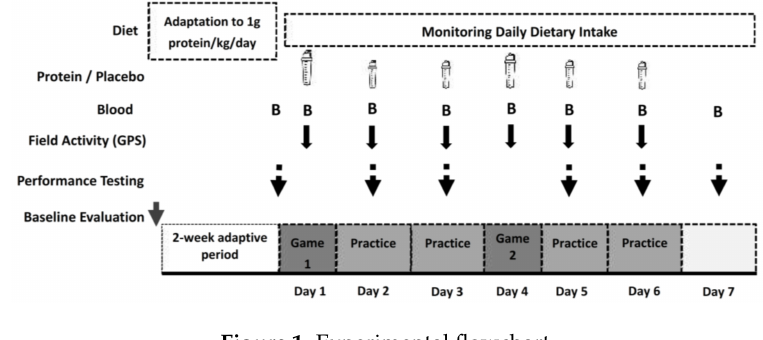
Figure 1. Experimental flowchart.